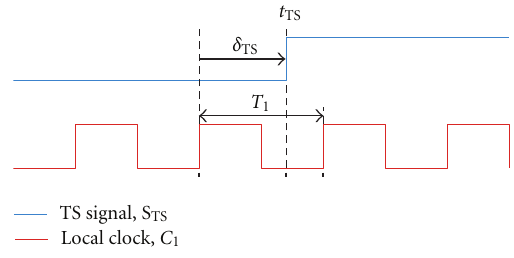
Figure 4: Timestamping error due to phase/frequency